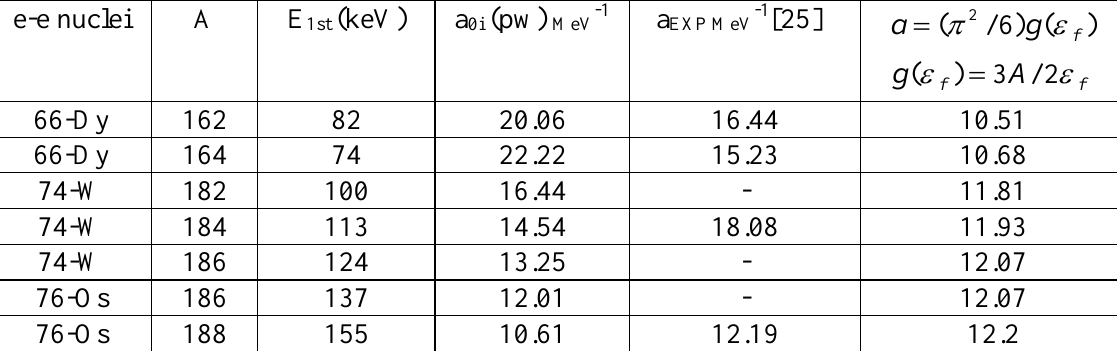
Table 1: Level density parameter for deformed nuclei by using different